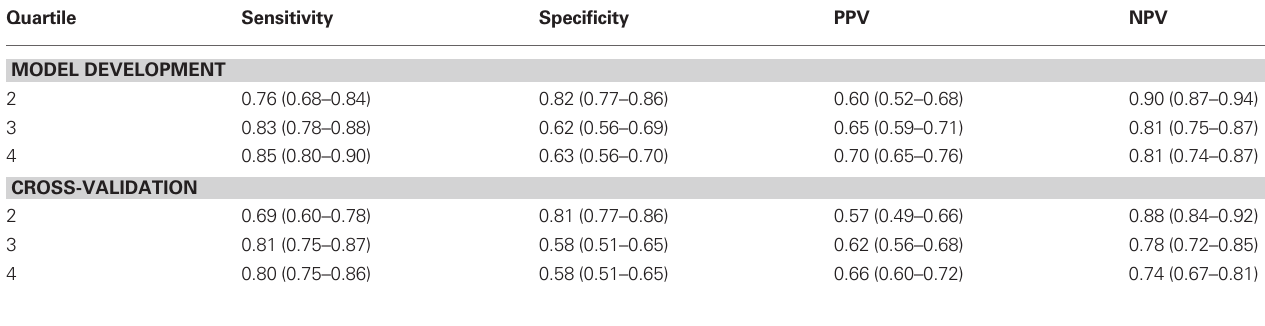
Table 4 | Sensitivity, specificity, positive predictive value (PPV), and negative predictive value (NPV) with 95% confidence intervals of the eeg-based future performance models after grouping the observed and estimated F -Measure into classes of unacceptable ( F -Measure < 0.80) and acceptable ( F -Measure ≥ 0.80) performance.